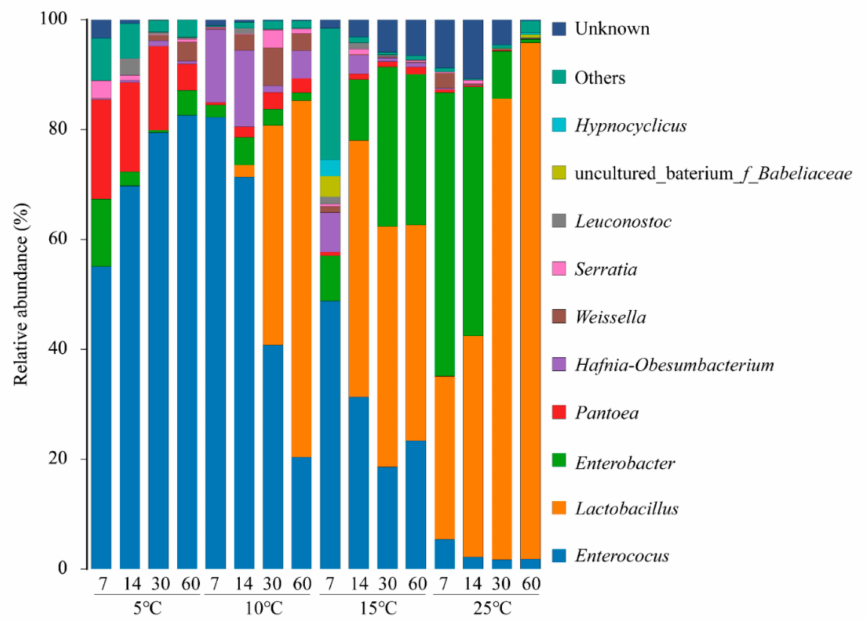
Figure 3. The microbial community of oat silages at the genus level revealed by single molecule, real-time sequencing technology